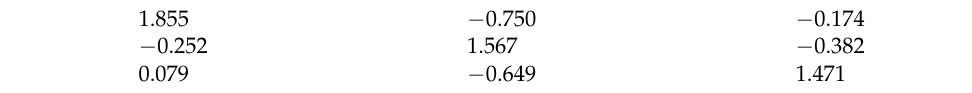
Table 6. CCM calculated using pseudo-inverse.